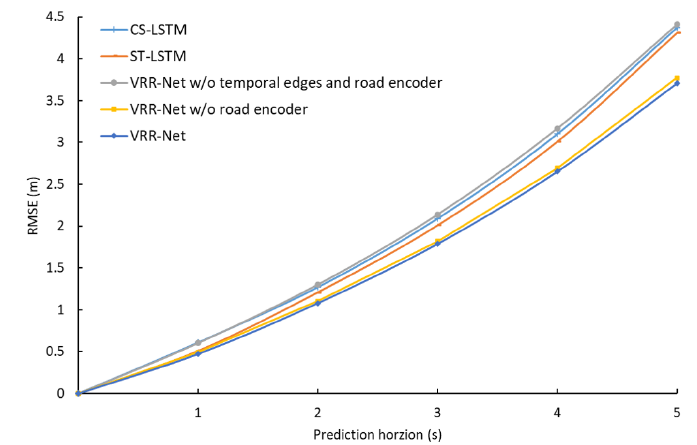
Figure 6. Comparison among the predictions of the three ablated versions of the proposed model under the RMSE loss function, where CS-LSTM and ST-LSTM are the baselines for